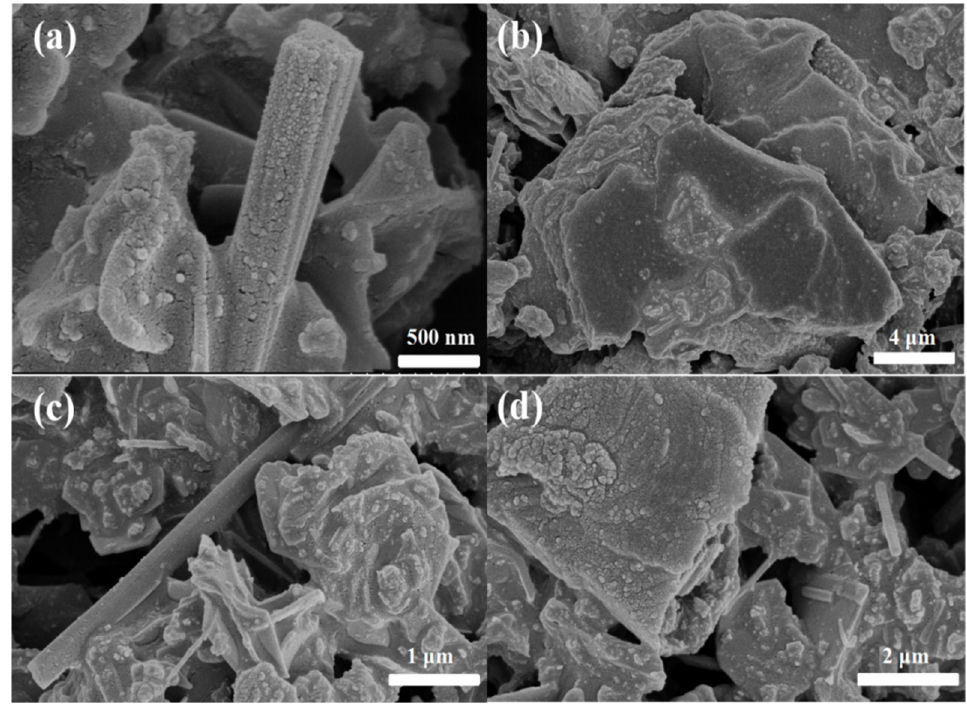
Figure 5. SEM images of ( a ) SnSe 2 , ( b ) g-C 3 N 4 , and ( c , d ) g-C 3 N 4 /SnSe 2